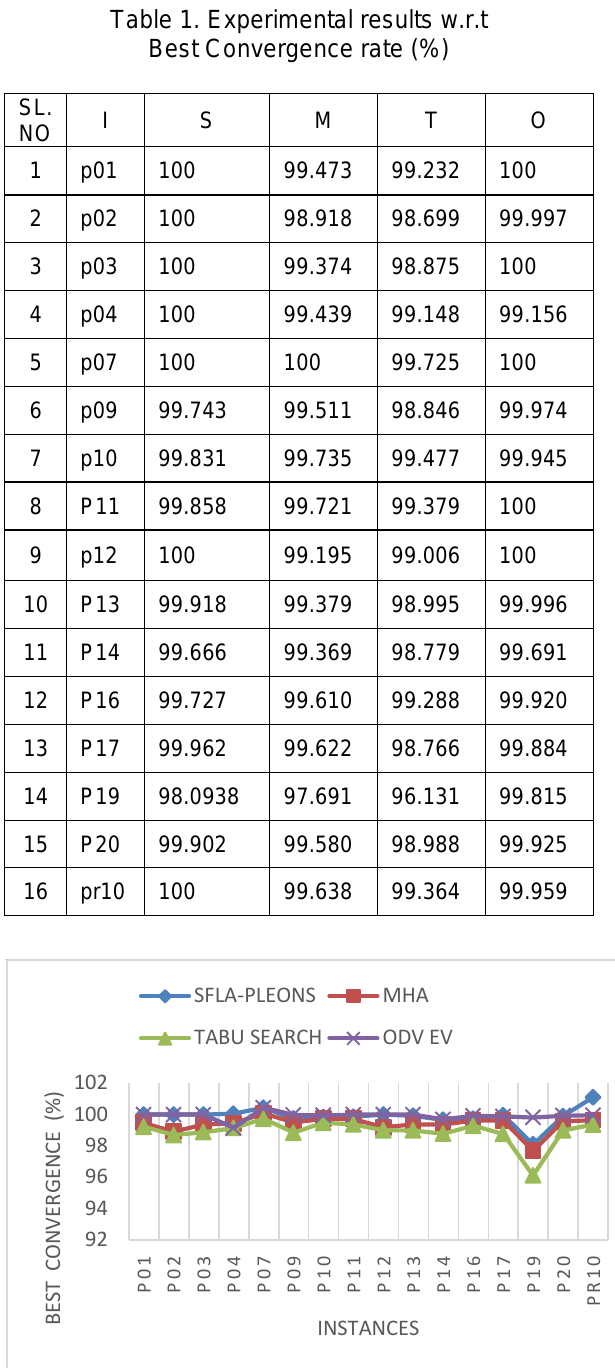
Table 1. Experimental results w.r.t